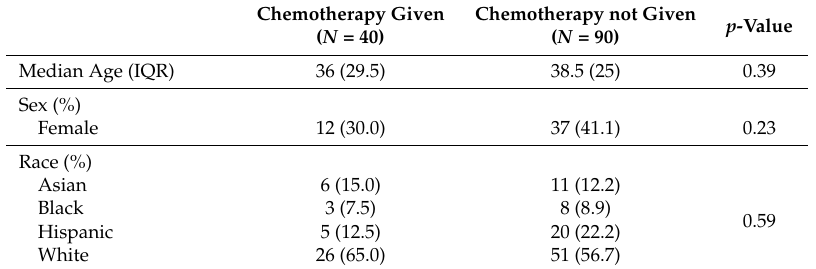
Table 4. Characteristics of early-stage patients who did and did not receive